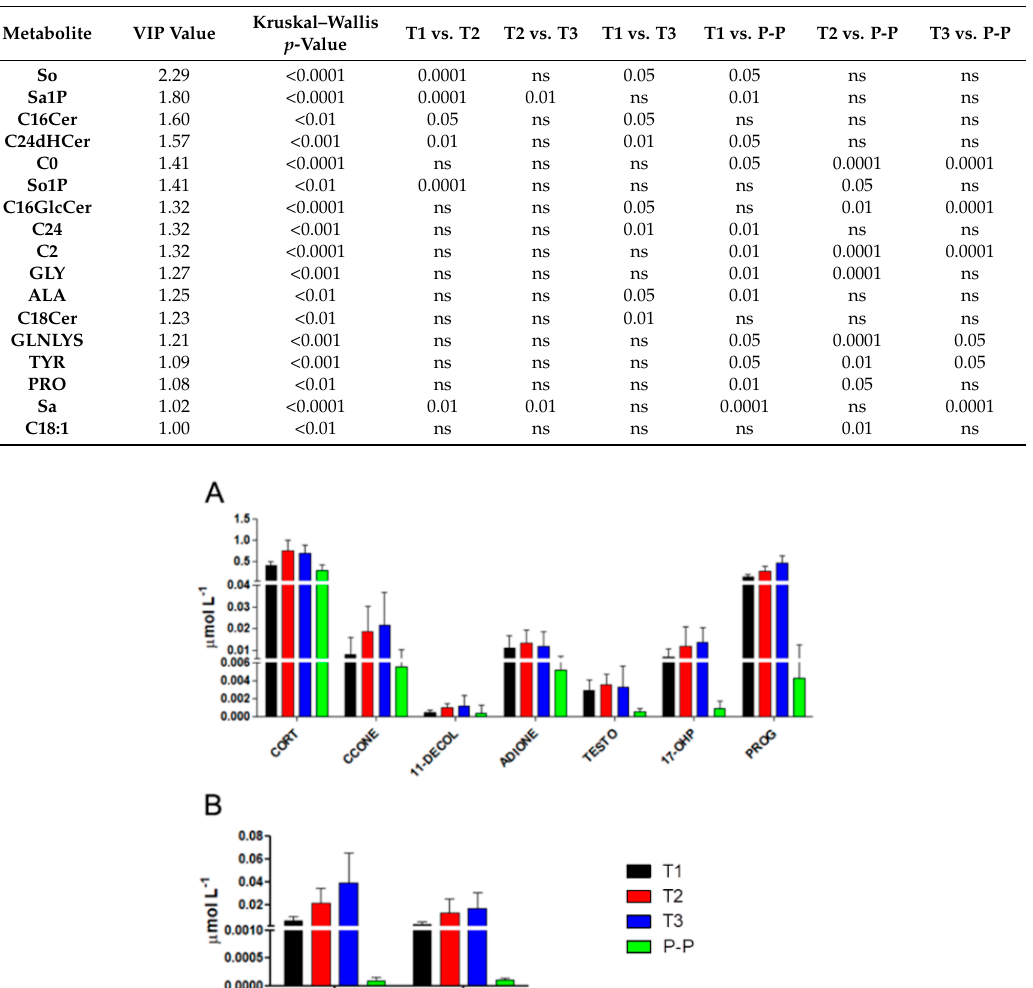
Table 1. Details of the most important metabolic values in PLS-DA classification. The p -Values of each time comparison are reported in the table, as well as not significant (ns) p -values. T1 vs. T2: First Trimester vs. Second Trimester; T2 vs. T3: Second Trimester vs. Third Trimester; T1 vs. T3: First Trimester vs. Third Trimester; T1 vs. post-partum (P-P): First Trimester vs. post-partum; T2 vs. P-P: Second Trimester vs. P-P; T3 vs. P-P: Third Trimester vs. P-P; the data were obtained by unpaired t